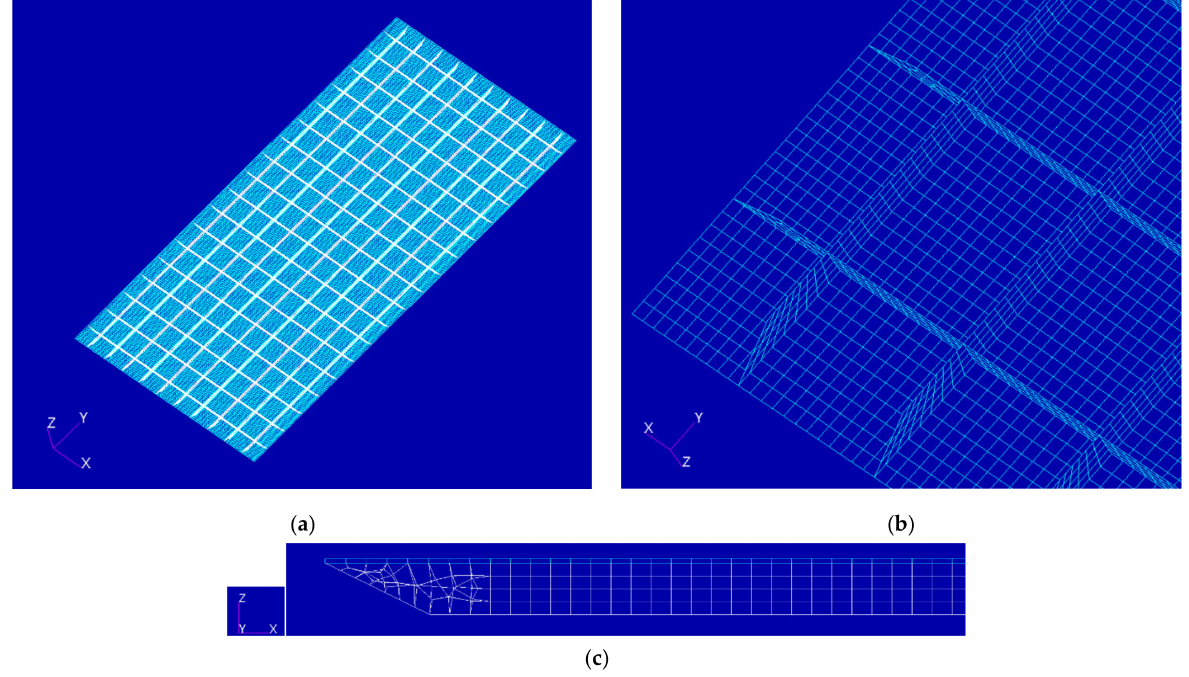
Figure 9. Orthogrid panel ( a ) perspective view of the underside, ( b ) zoom of ( a ) near corner, and ( c ) cross-section showing the skin (in blue) and a tapered stiffener (in